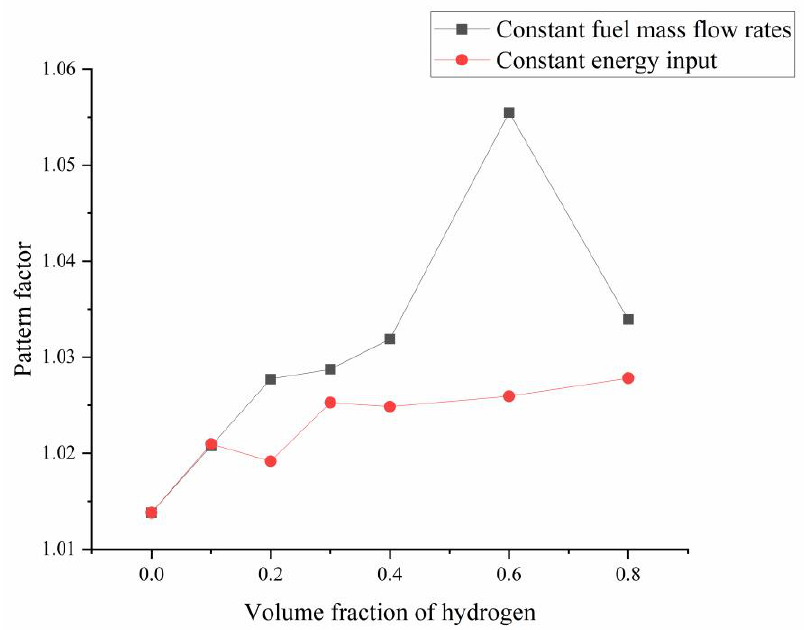
Figure 13. Pattern factor distribution at the outlet position of the combustor for different fuel condi- tions.